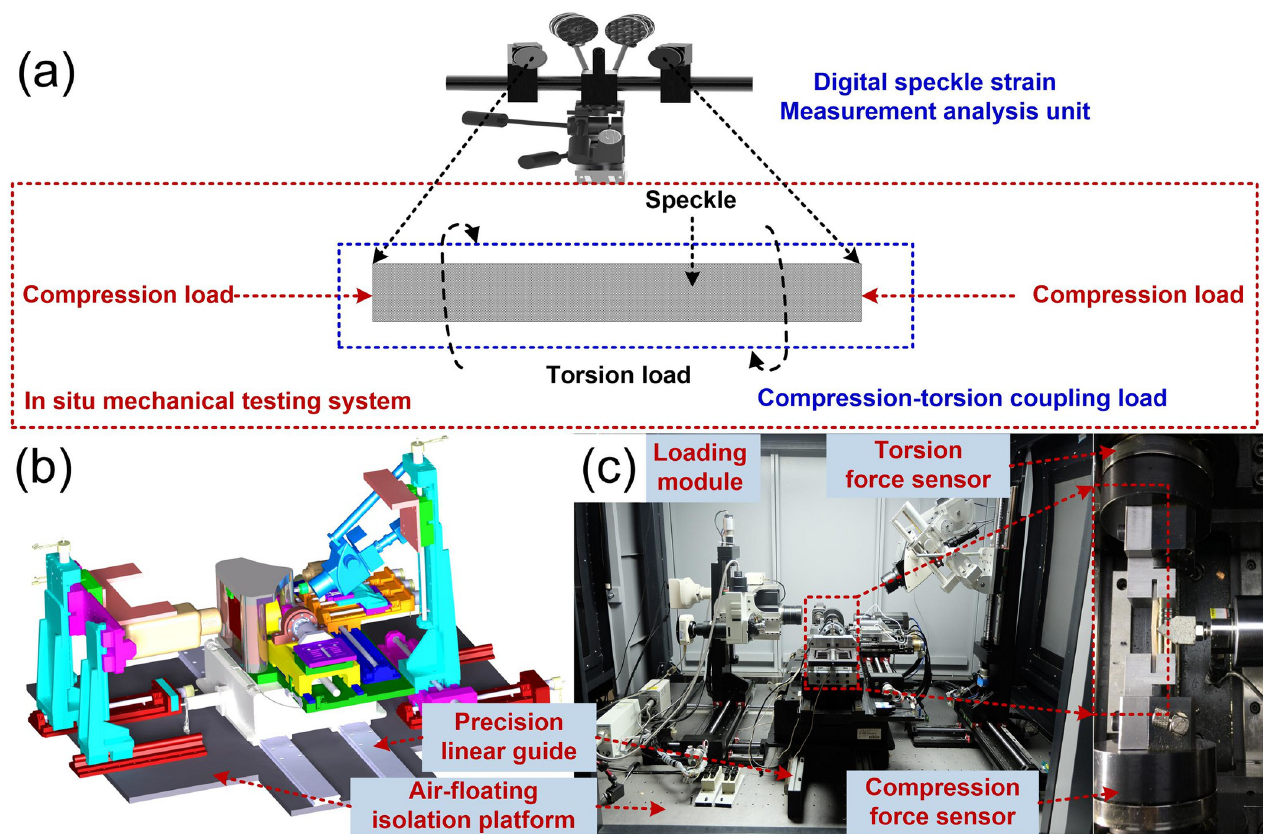
Fig 2. In-situ testing system of mechanical property of materials under multiple load